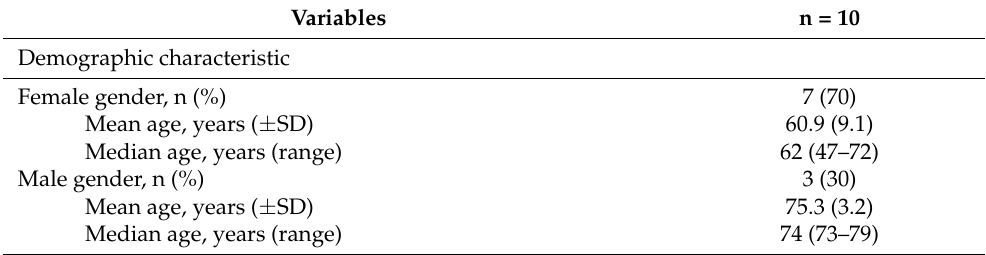
Table 1. Patient characteristics for patients included in the Luminex and immunohistochemistry analysis. Variables n = 10 Demographic